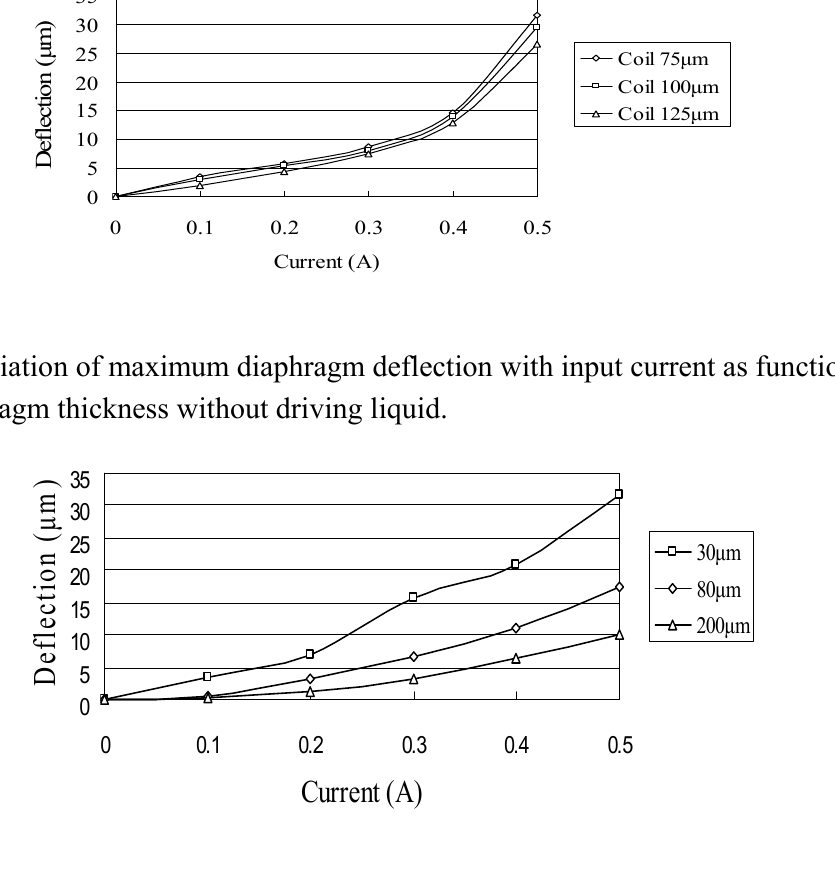
Figure 8. Variation of maximum diaphragm deflection with input current as function of magnetic layer thickness without driving